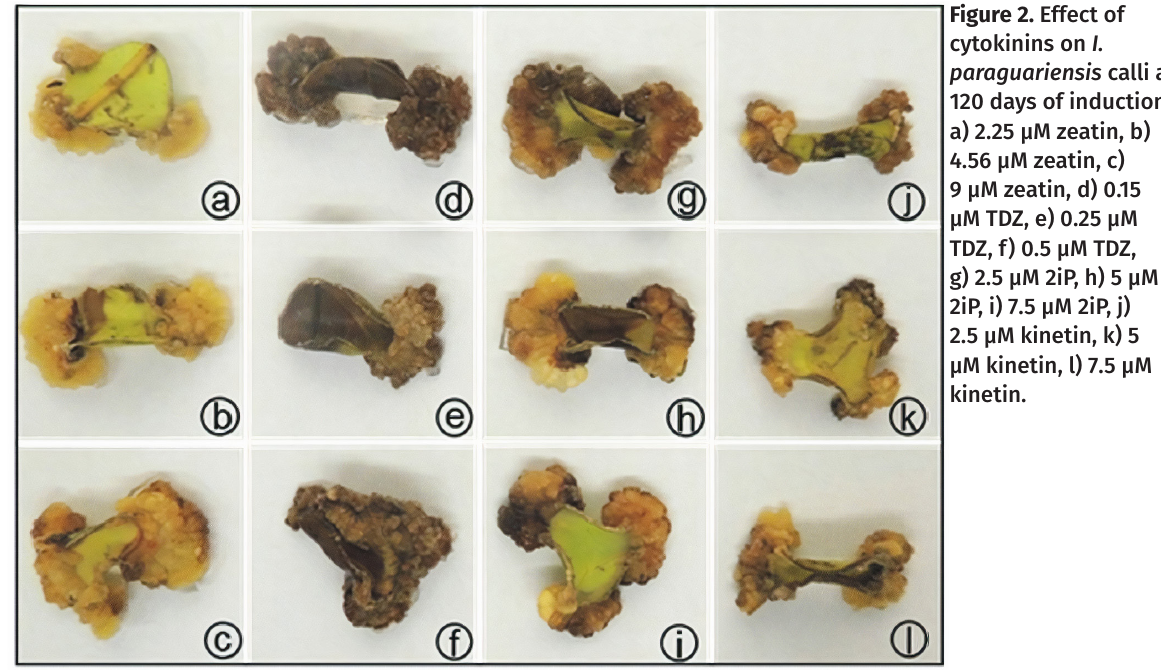
Figure 2. Effect of cytokinins on I. paraguariensis calli at 120 days of